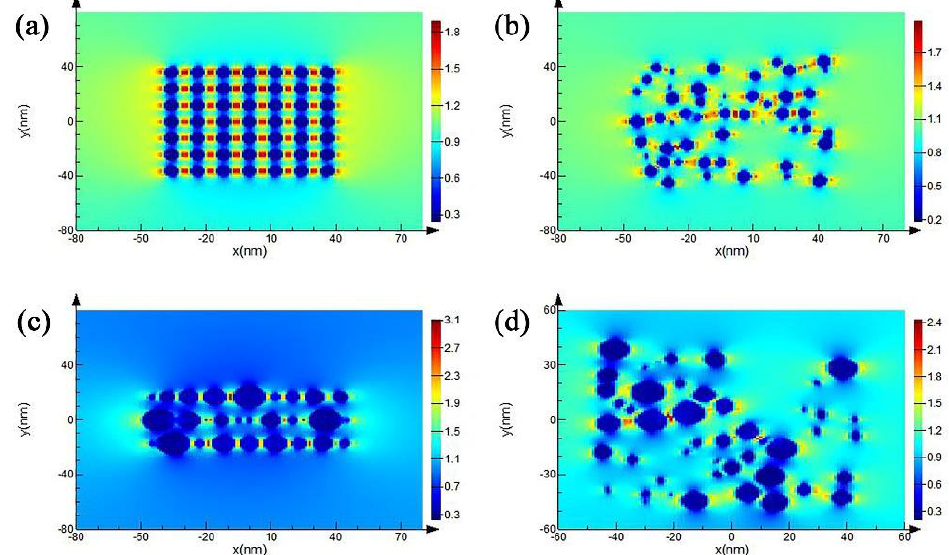
Figure 6. Cross-section of the electric field distributions of the layered ( a ) and randomly distributed ( b ) nanoparticles of the same diameter, and the layered ( c ) and randomly distributed ( d ) nanoparticles with different diameters, at a wavelength of 527 nm.